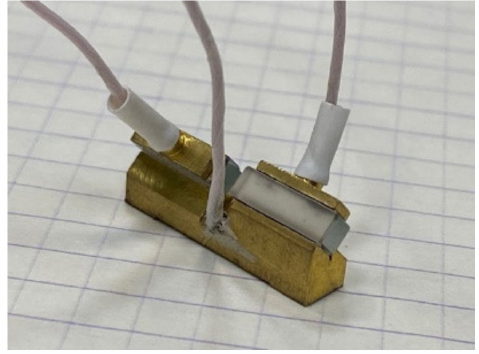
Figure 3. Pockels cell based on Y-cut KTP crystals